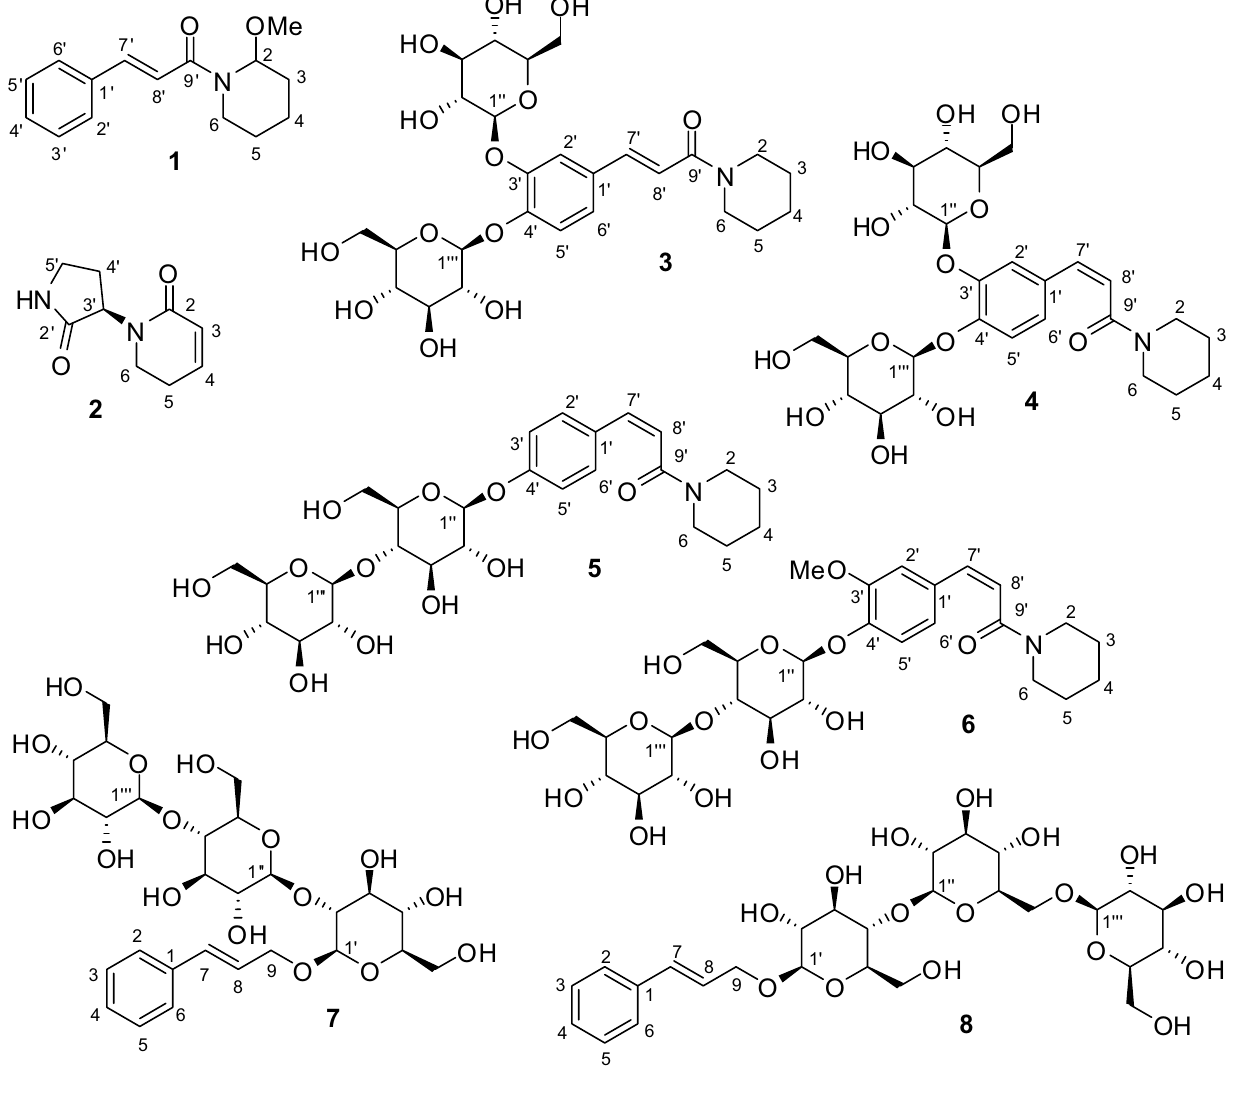
Fig. 1 Chemical structures of new compounds ( 1 – 8 ) from Piper